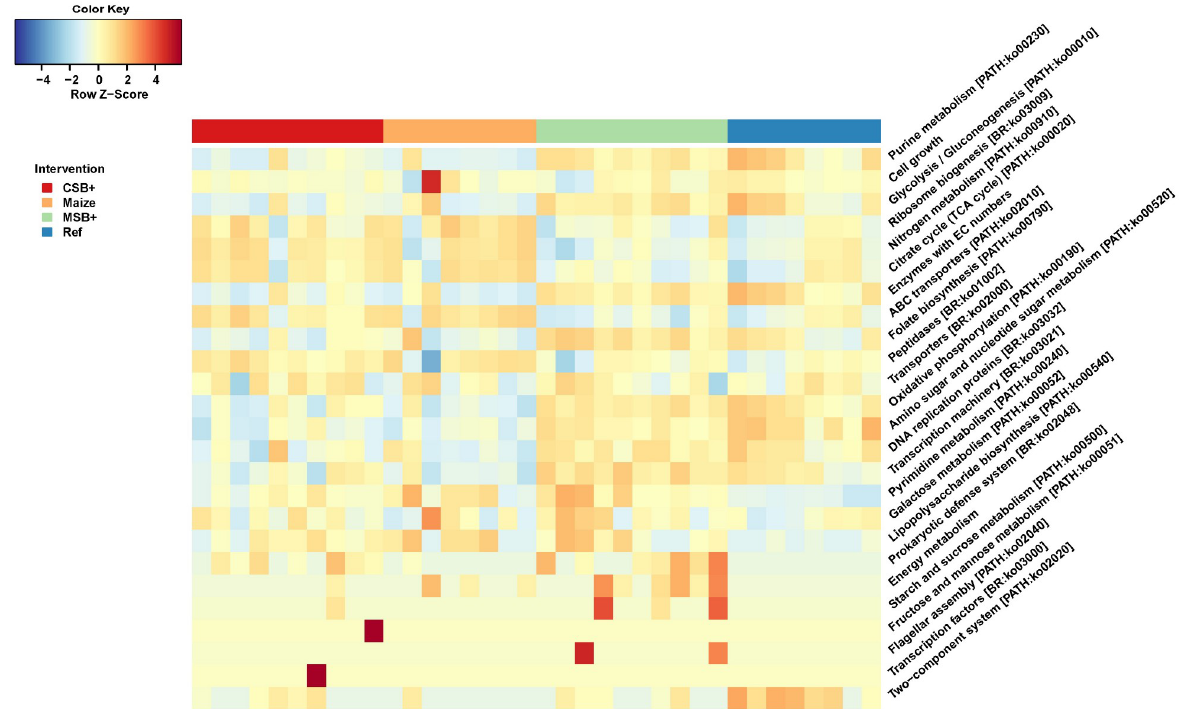
Fig 6. Microbial functional capacity predicted by PICRUSt 2. The heatmap showing the differentially enriched pathways identified by LEfSe (LDA scores > 3). The relative abundances of KEGG pathways were visualized in heatmap after Z-score normalization. For CSB+ and MSB+, n = 10; For Maize and Ref, n =